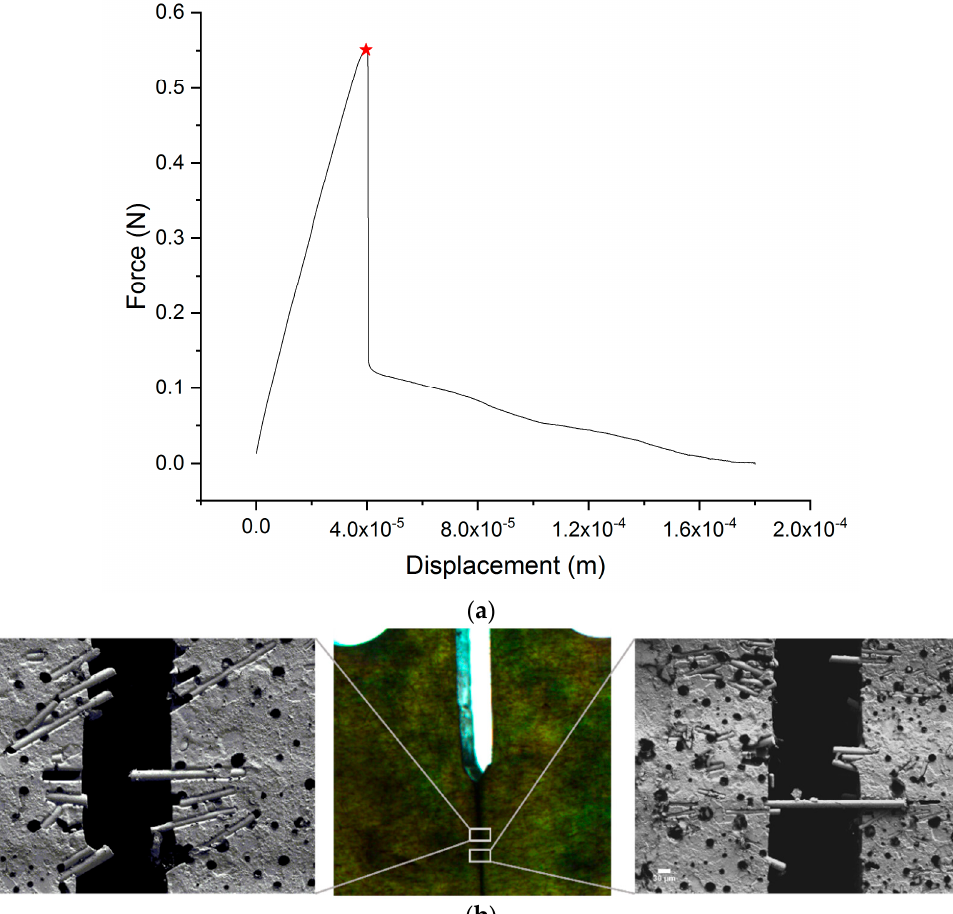
Figure 10. Toughening mechanisms. ( a ) Force-displacement curve of a pull-out test performed on a single magnetized glass fiber (MGF) and Epoxy ( b ) Scanning Electron Microscopy (SEM) images of the crack walls after fracture, showing some of the main toughening mechanisms involved in the extrinsic toughening of the composite: fiber pull-out and fiber bridging. Note: the black spots in the SEM images are traces of artifacts in the Silicon mold surface; they do not indicate voids in the specimen volume. Table 4. Composite Properties.